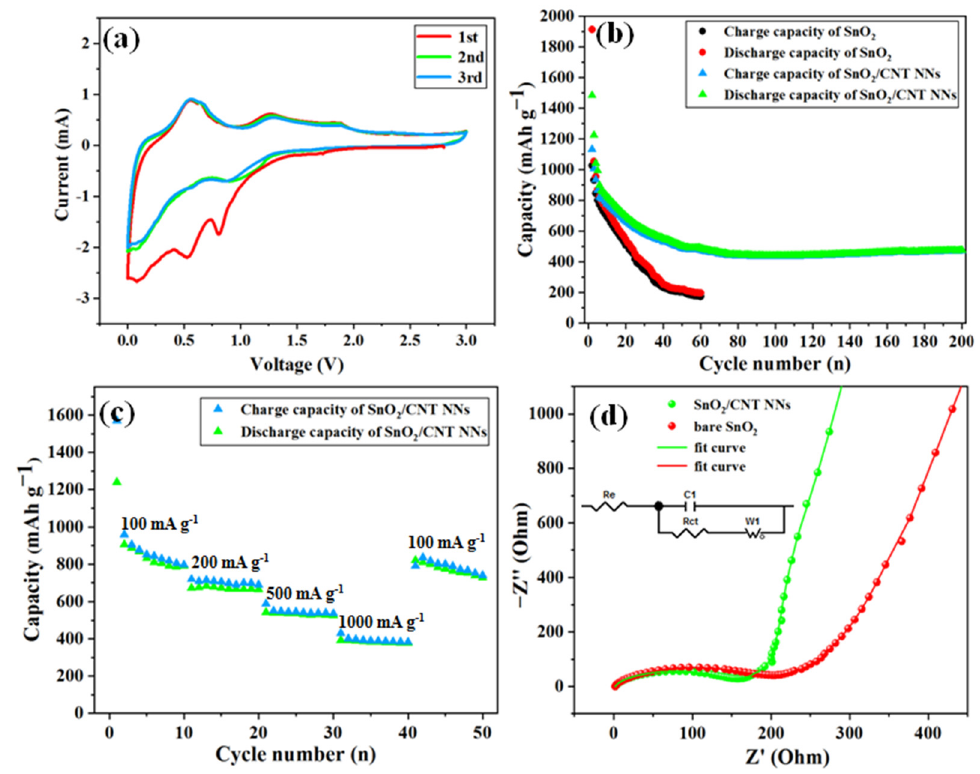
Figure 6. ( a ) CV curves of the SnO 2 /CNT NNs composites at a scanning rate of 0.2 mV s − 1 , ( b ) cycling performance at 0.01 − 3 V and 100 mA g − 1 of the SnO 2 /CNT NNs composites and rare SnO 2 , ( c ) the rate performance of the SnO 2 /CNT NNs composites at various current densities, and ( d ) EIS spectra of the bare SnO 2 and SnO 2 /CNT NNs composites at 25 ℃ from 0.1 to 100 kHz.